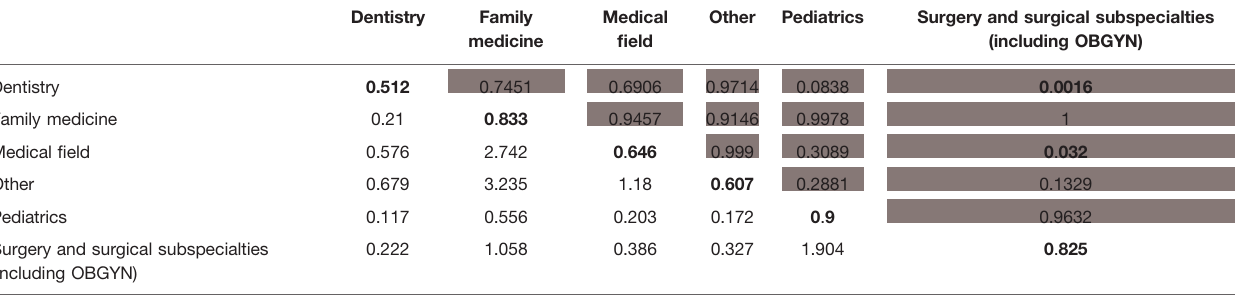
TABLE 4 | Pairwise comparisons of specialties.